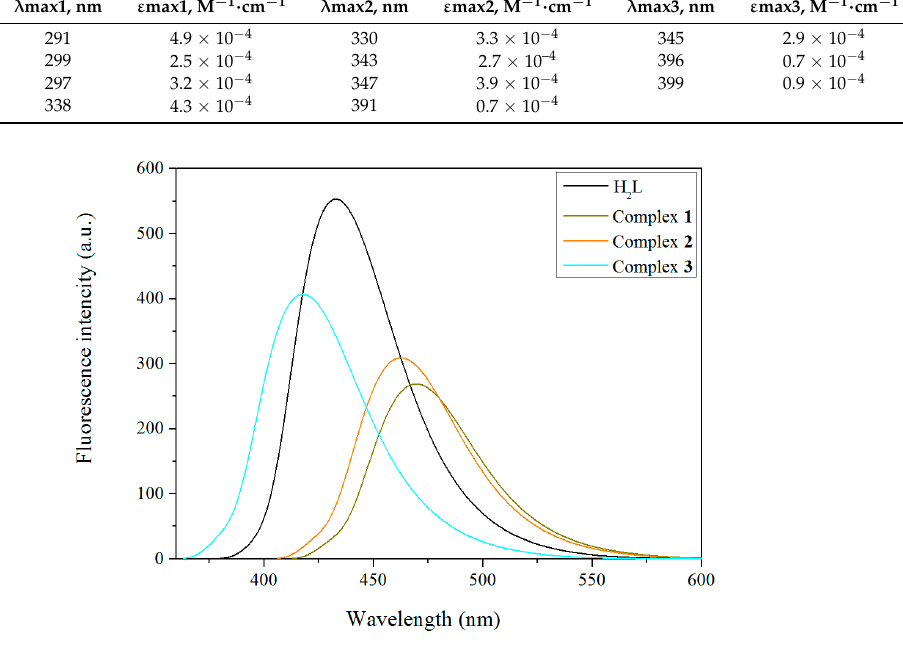
Figure 3. Emission spectra of H 2 L and its complexes 1 , 2 and 3 in dichloromethane (2.5 × 10 − 5 M) upon excitation at 351 nm.